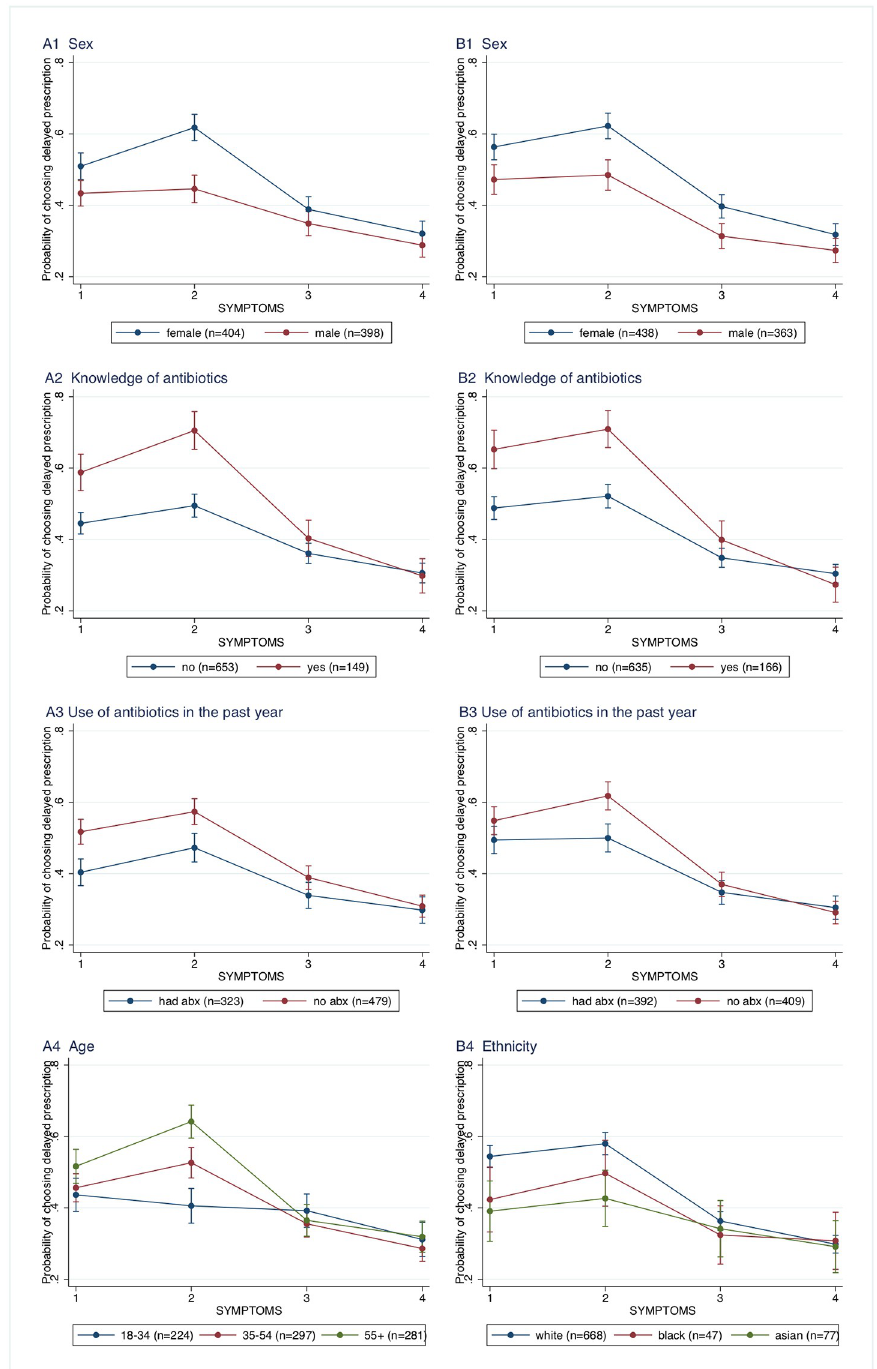
Fig 1. The probability of choosing delayed prescription varies by respondent characteristics across symptom types. (A) Adults. (B) Parents. Symptoms: 1 –sore throat and swollen glands; 2 –chesty cough and runny nose; 3 –sore throat, swollen glands, and fever; and 4 –chesty cough, fever, and pain on breathing. Bars indicate 95% CIs. Ethnicity: White includes “white,” “other,” and “prefer not to say,” and black includes “black” and “mixed ethnicity.” abx, antibiotics; CI, confidence